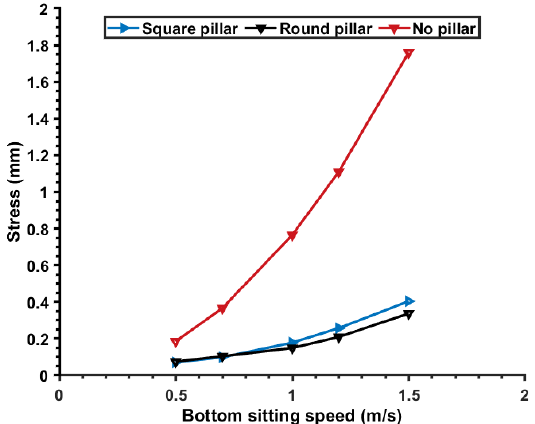
Figure 10. Relationship between the subsidence depth and the initial speed. Table 2. Statistical table of subsidence depth unit: mm.